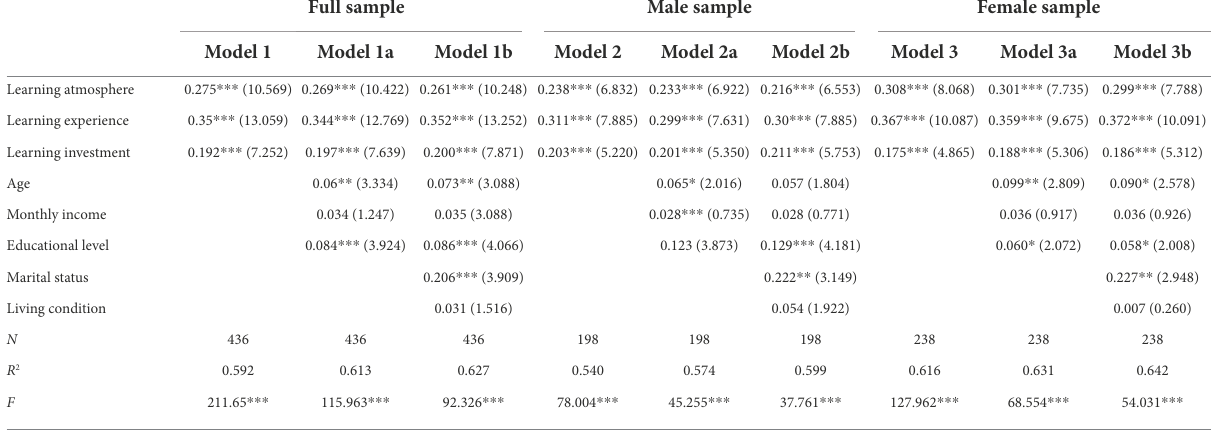
TABLE 6 Regression model for the subjective well-being of male and female older